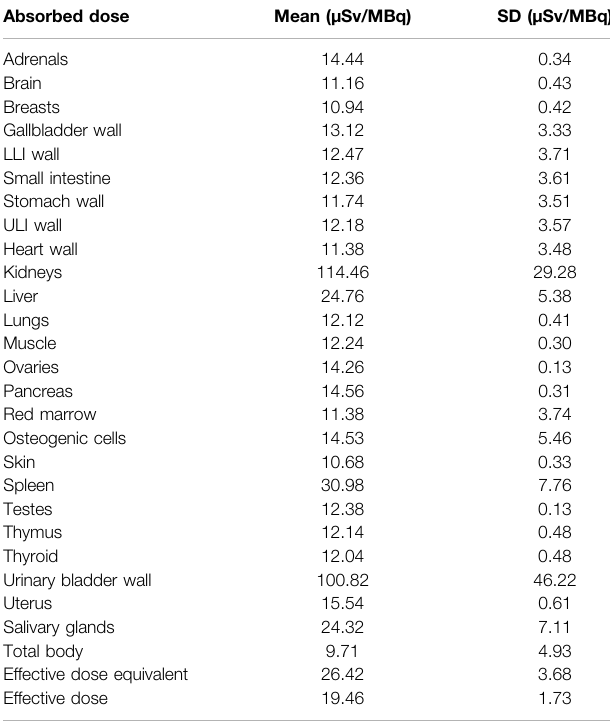
TABLE 3 | Estimated absorbed organ doses and effective dose for 68 Ga-DOTA- DiPSMA in healthy